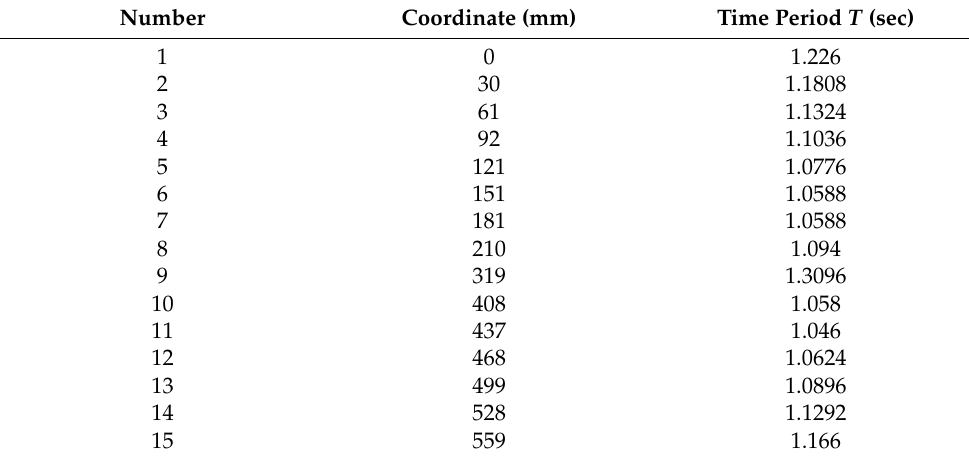
Table 2. Results from experimental to determine the